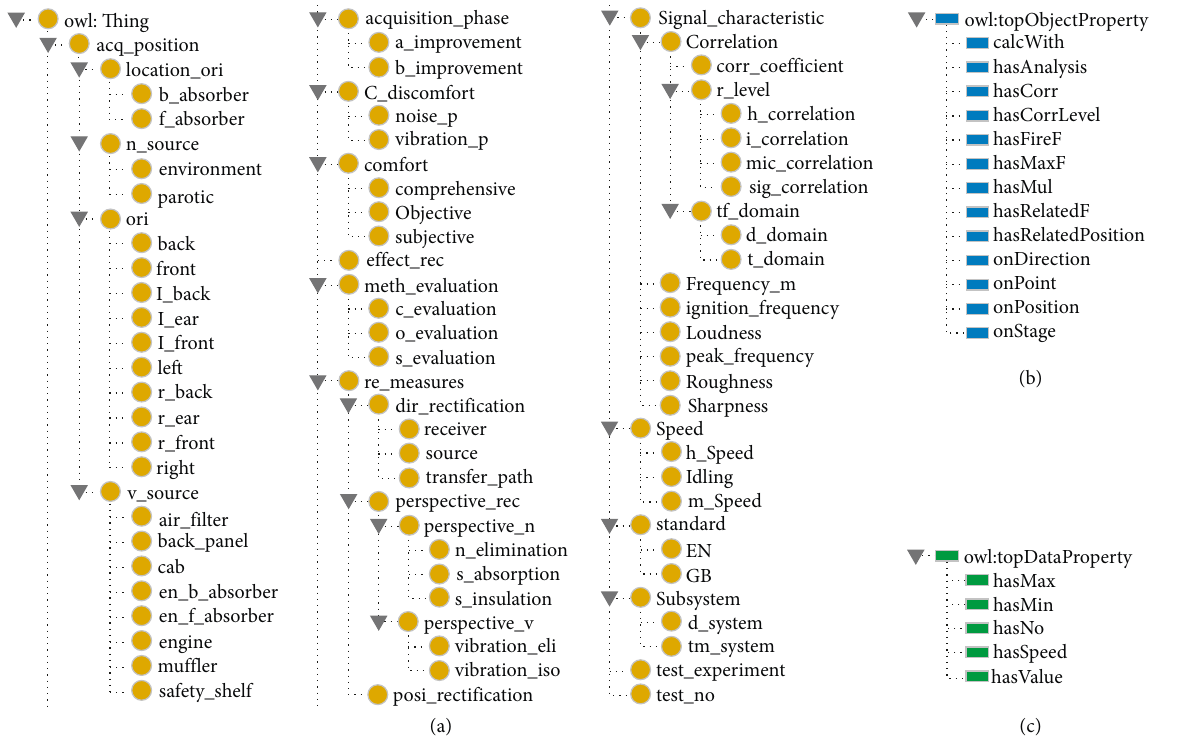
Figure 4: Developed ontology in Prot´eg´e-OWL